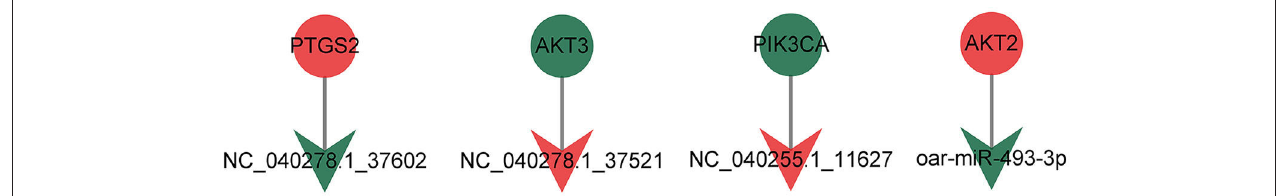
FIGURE 8 | The targeting relationship of genes in Regulation of lipolysis in adipocytes.